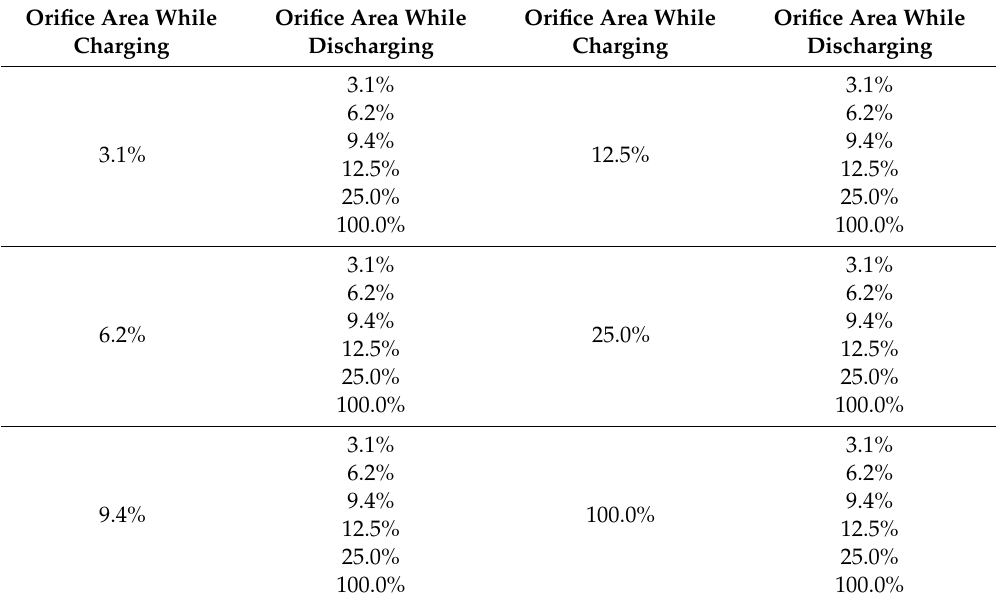
Table 6. List of experiments performed in the hydraulic test bench.